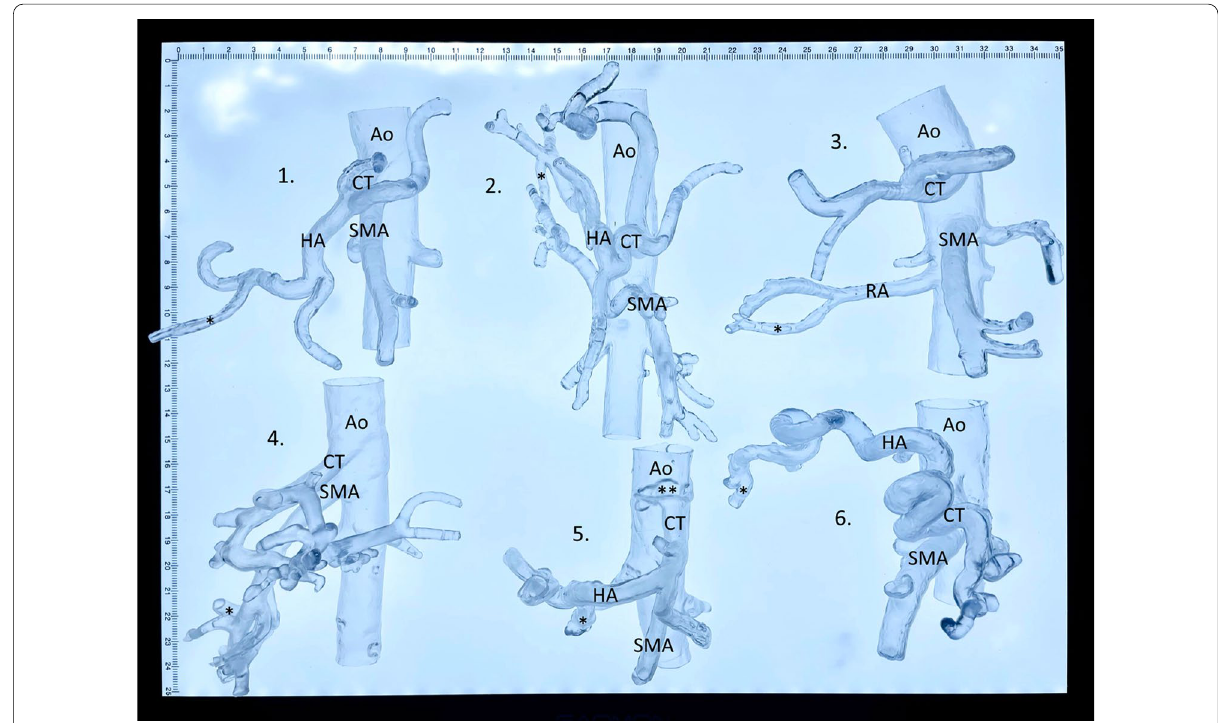
Fig. 3 3D printed vascular models. A set of 3D printed visceral vascular models with patient-specific anatomy based on preprocedural computed tomography scans to demonstrate the vascular dimensions and the level of details for procedure simulations. 1. Spontaneous bleeding from ruptured cyst in polycystic liver disease, 2. spontaneous hepatic tumor bleeding, 3. post-surgery kidney bleeding, 4. pancreas tumor bleeding from the inferior pancreaticoduodenal artery, 5. gastroduodenal artery bleeding from duodenal ulcer, and 6. liver metastasis bleeding in esophageal